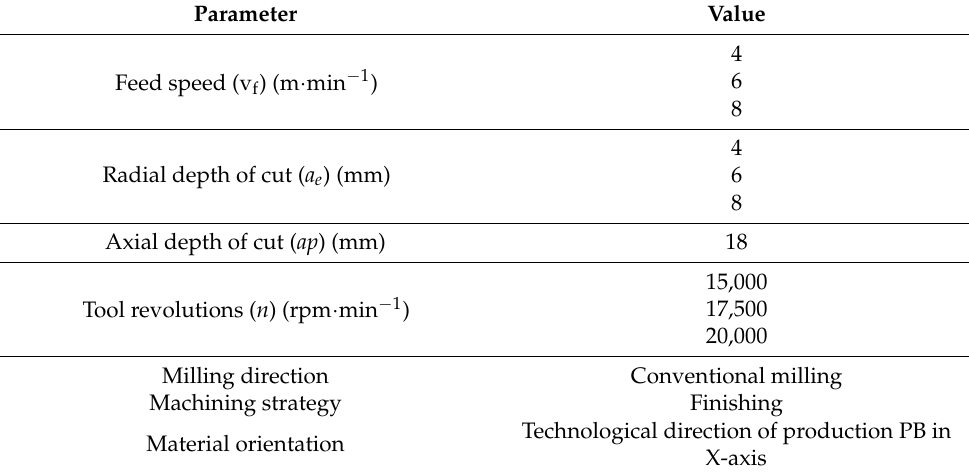
Table 2. Parameters of milling process.